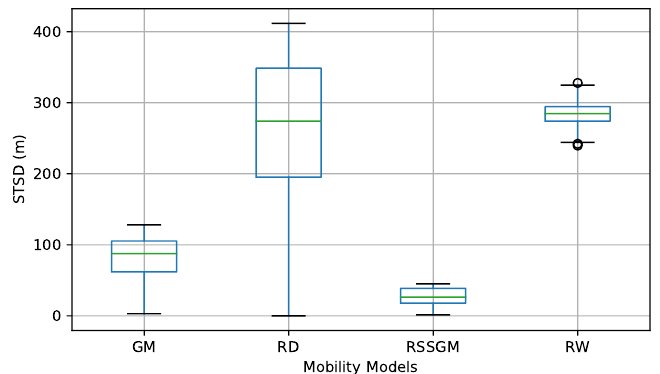
Figure 7. STSD values with different mobility